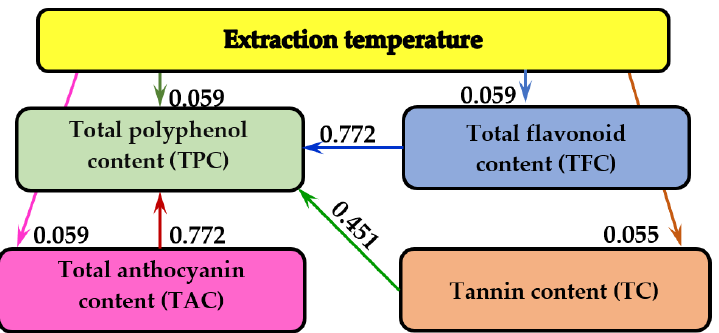
Figure 3. Analysis of mutual information on the influence of extraction temperature on the TPC, TFC, TAC and TC in GME.